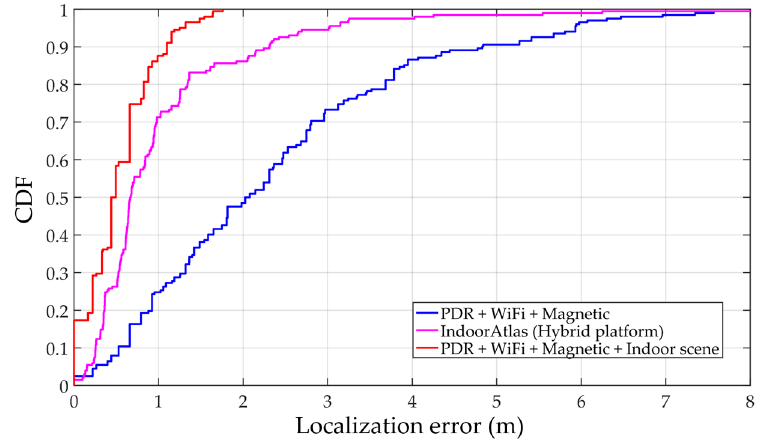
Figure 16. Empirical cumulative distribution function (CDF) of three different solutions. The proposed solution outperformed the conventional approaches without scene constraint.